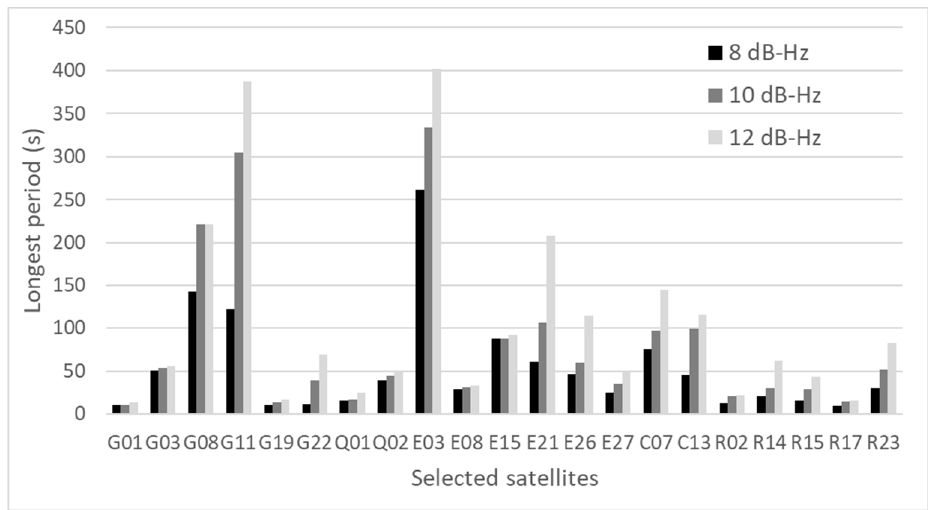
Figure 11. Longest period of selected satellites for three thresholds (high-rise buildings).